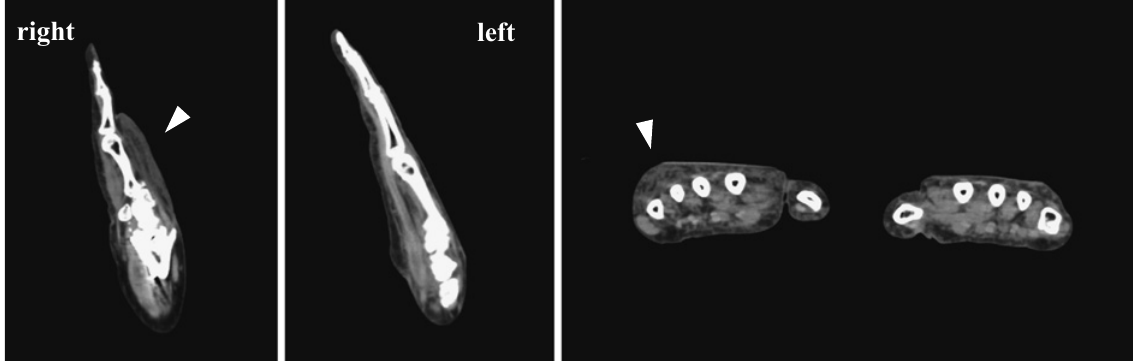
Figure 1. Computed tomography of both hands. Swelling is observed in both hands. The white arrow indicates the severe swelling and turbidity of adi- pose tissue in right